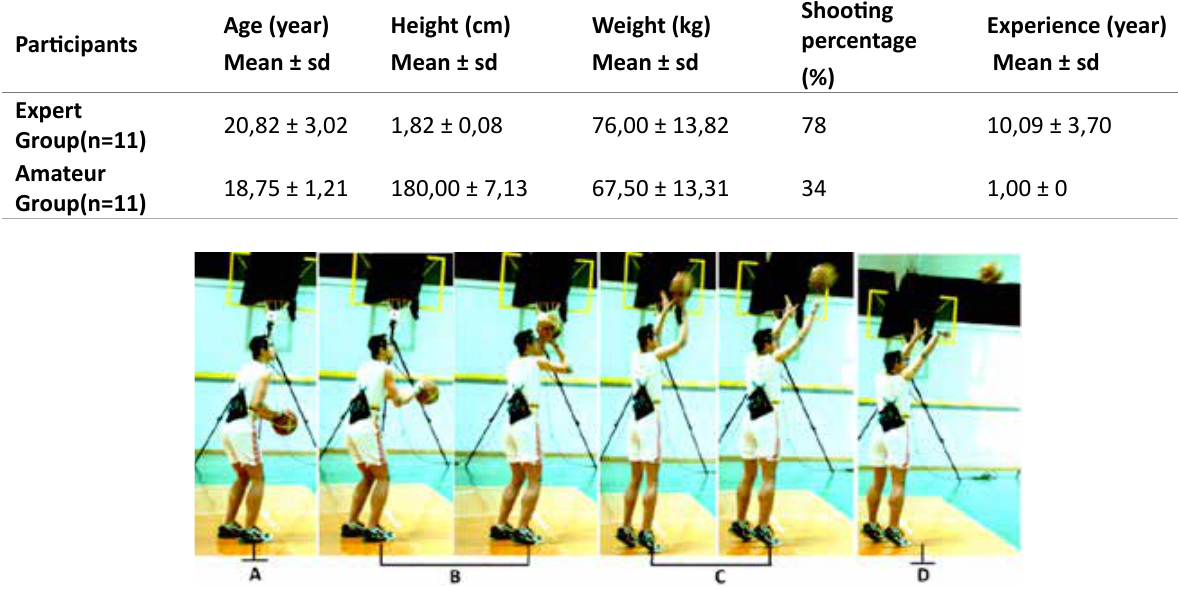
Fig. 1. Phases of free-throw A- Preparation phase: It is the process in which visual information is received before starting the action; B- Acceleration: It is the process in which the shooting movement begins, phased as its beginning and end; C- Shooting: the moment of the shooting and the process of handing the ball; D- Flight: It is the process that starts with the last wrist movement after the ball is released and ends with the release